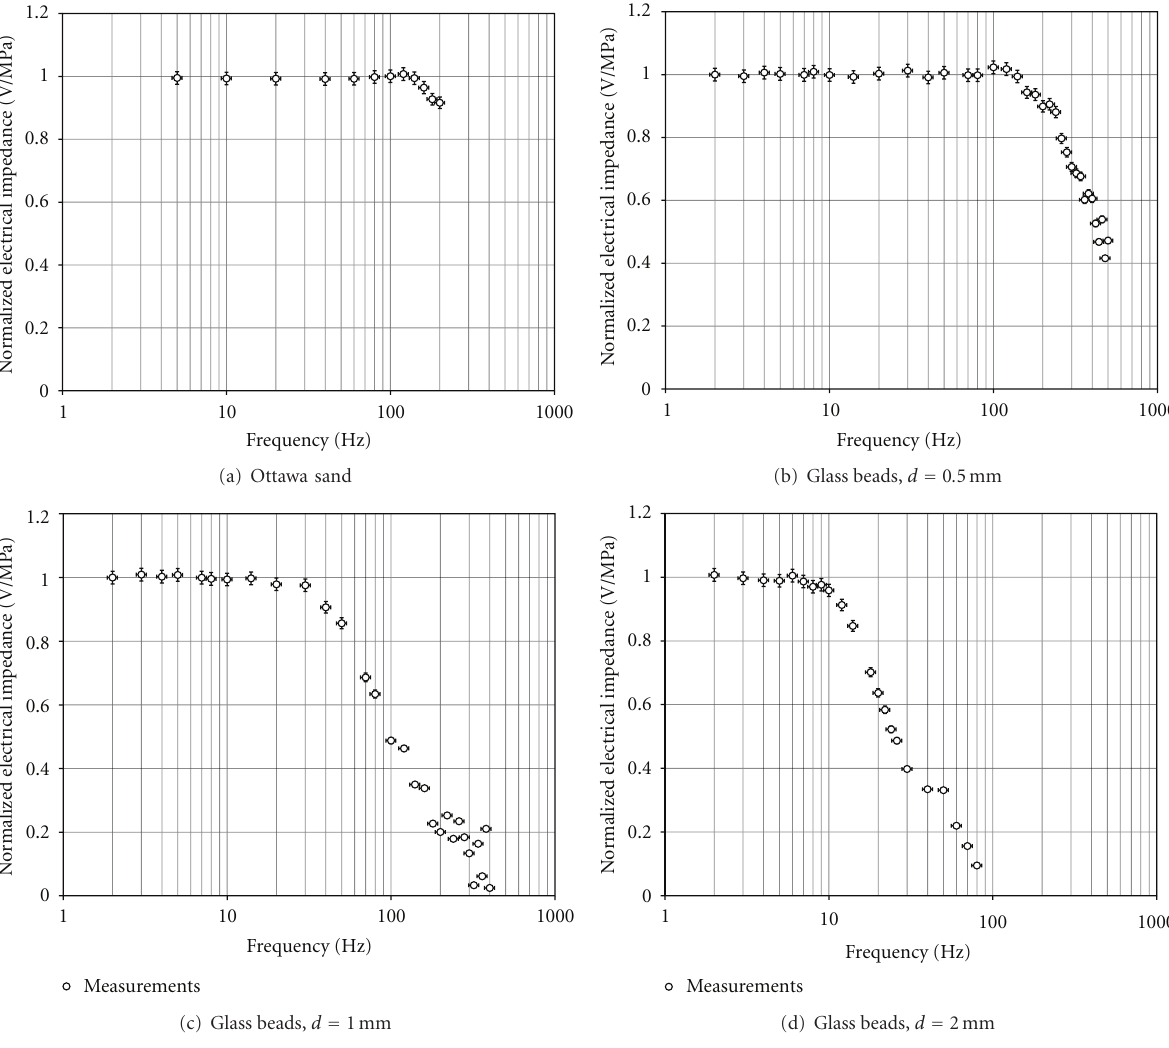
Figure 2: Normalised electrical impedance data for (a) Ottawa sand, and glass beads with (b) d = 0 . 5 mm, (c) d = 1 mm, and (d) d = 2 mm.